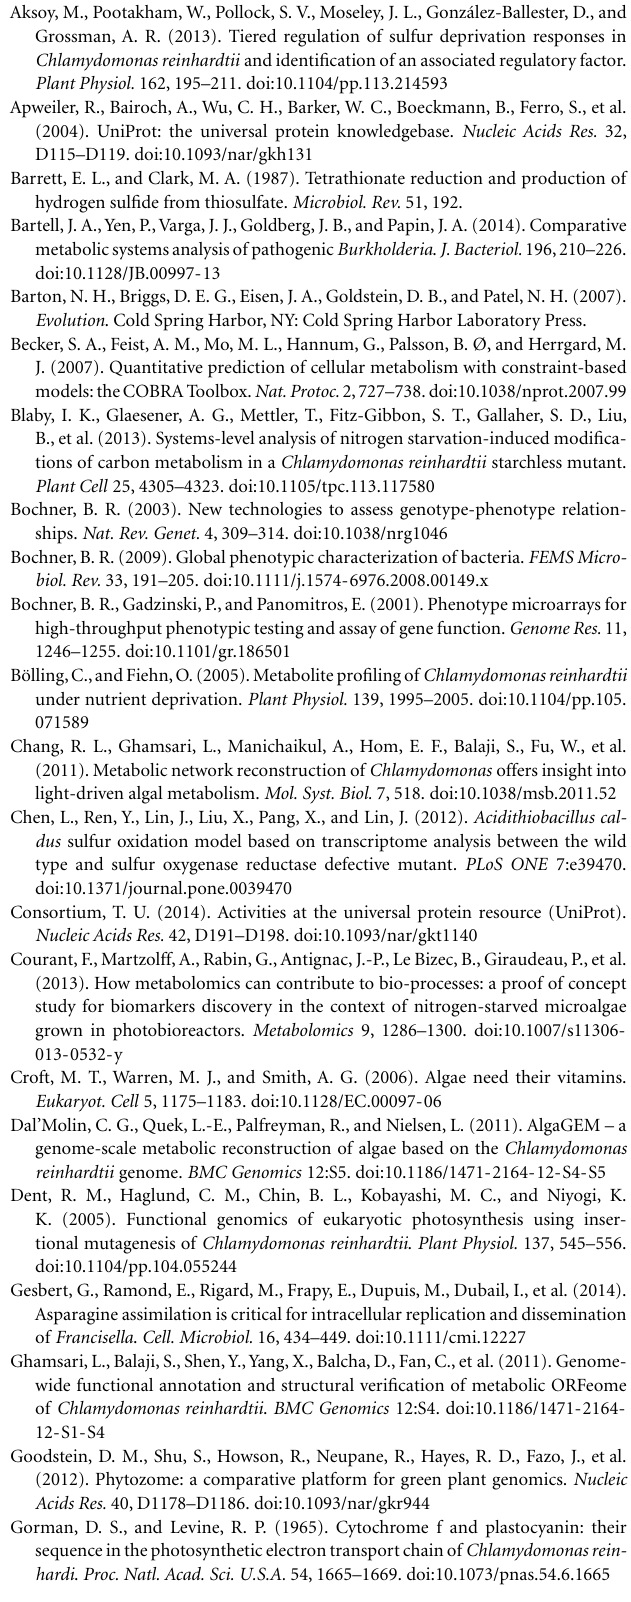
Figure S1 | Phenotype microarray results for plates 1–4, and 6–8